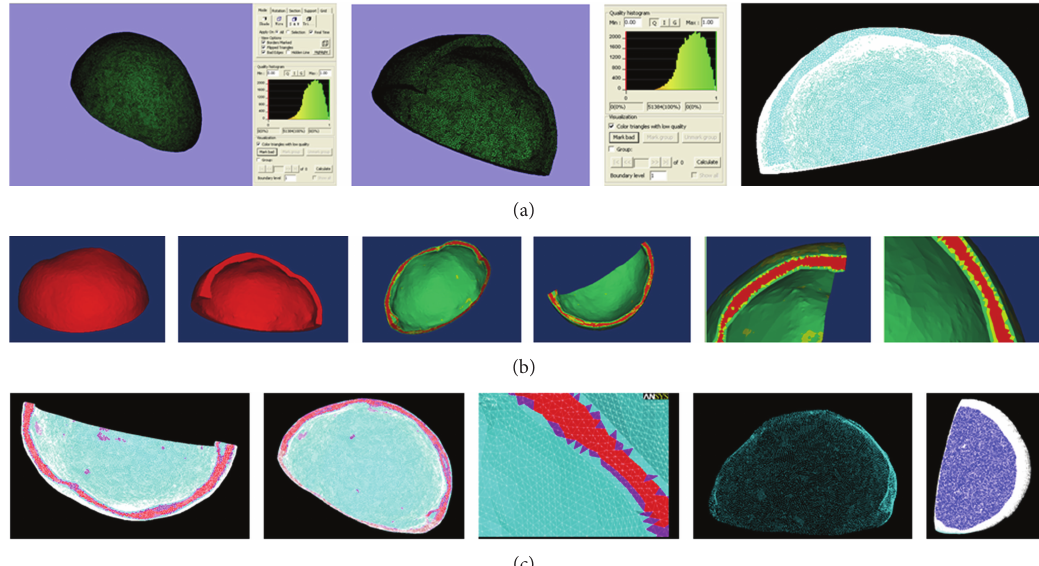
Figure 17: The cranial cavity model after smooth processing and mesh division.